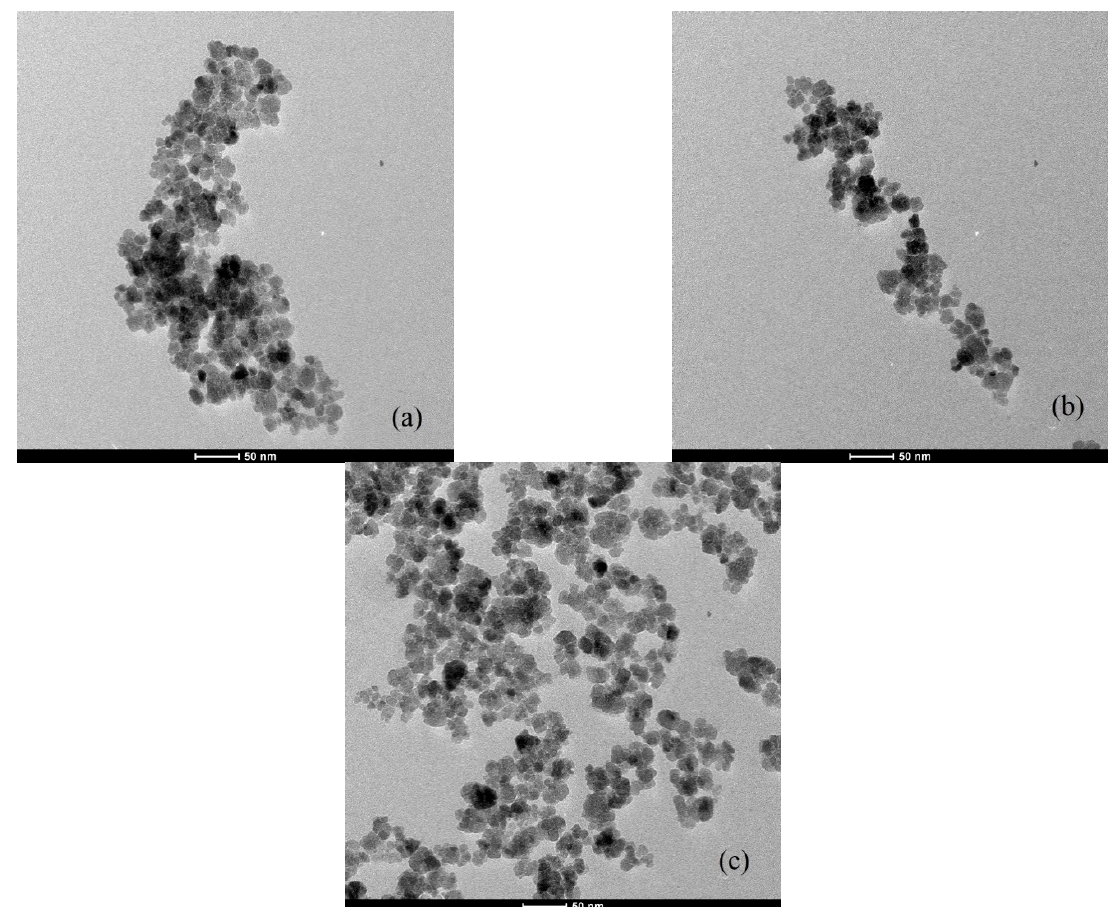
Figure 9. TEM micrographs for samples ( a ) Gd IO/0, ( b ) Gd IO/0.02, and ( c ) Gd IO/0.04.